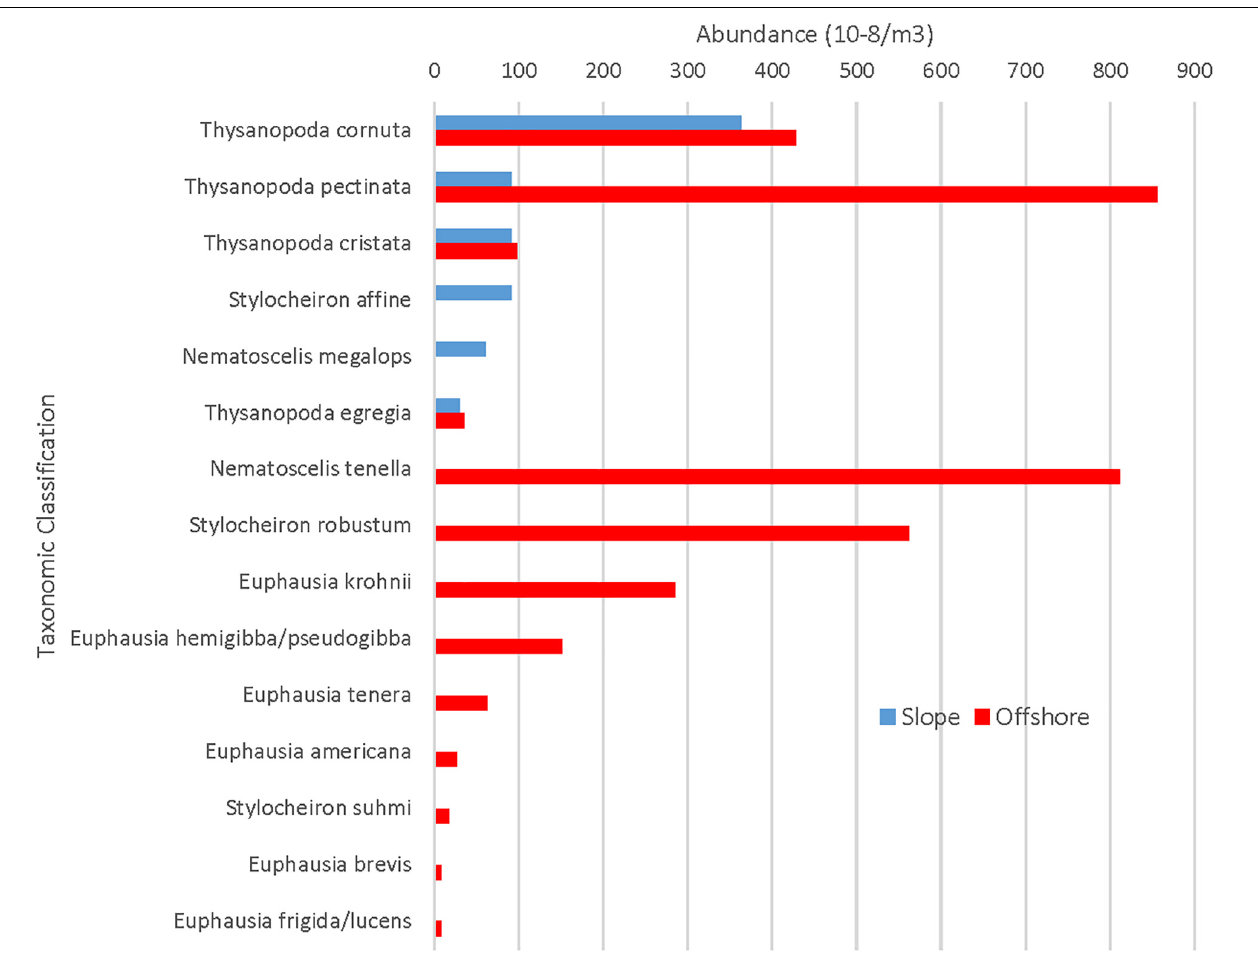
FIGURE 5 | Slope and offshore abundances for rare euphausiids. X -axis maximum value is substantially lower than that of Figure 4 .